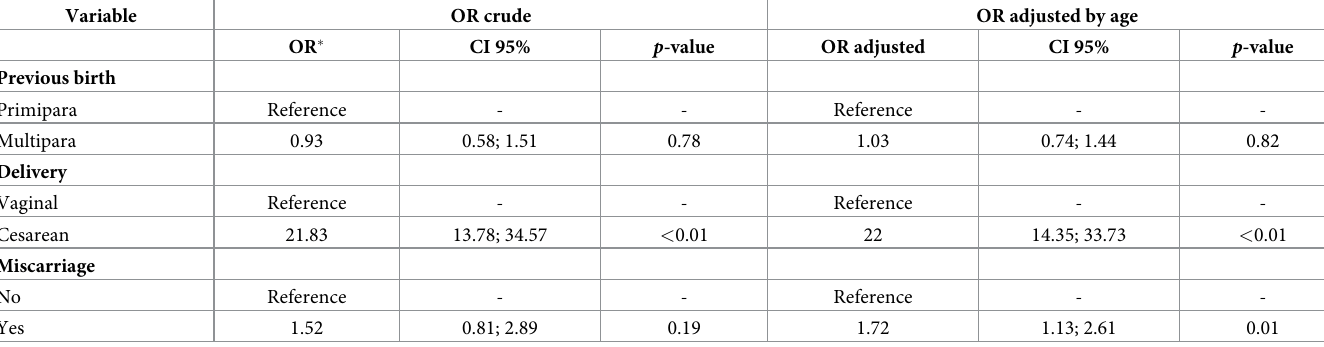
Table 4. Analysis of crude and age-adjusted odds ratio of obstetric outcomes variables of pregnant women with